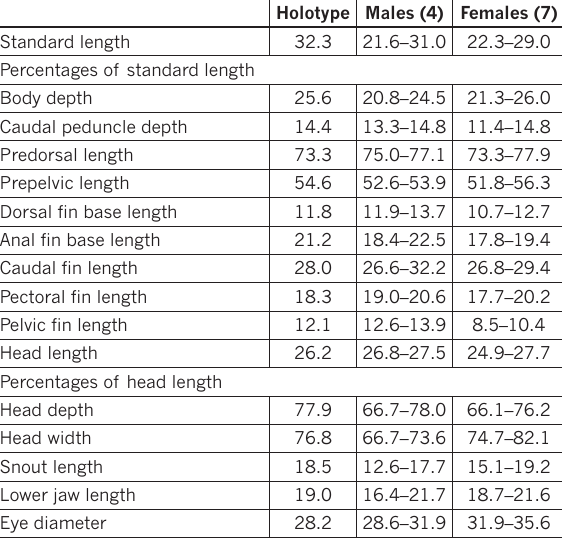
Table 1. Morphometric data for the holotype and paratypes of Melanorivulus interruptus sp.